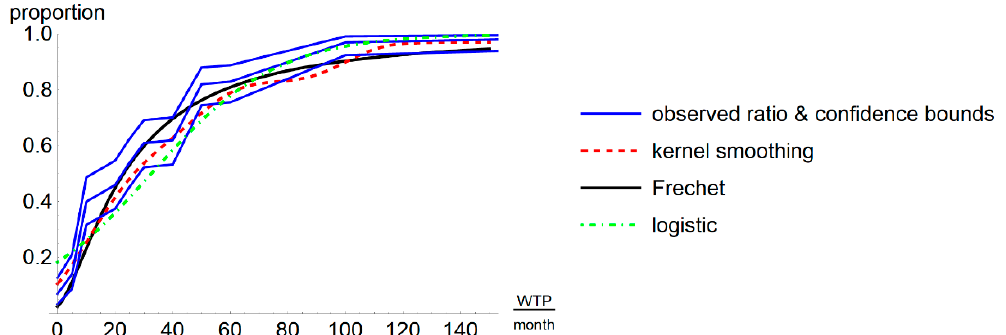
Figure 7. Cumulative distribution functions related to users’ WTP (INR/month), based on the Raisen 2015-survey (100 data). It plots the observed proportions for the percent of HHs willing to pay at most x INR/month sewerage charge and the one-sided 95% Clopper–Pearson confidence limits (blue; Section 9, Equation (3)), the cumulative smooth-kernel distribution function (dashed red), the cumulative Frechet distribution (black) and the cumulative logistic distribution (dot-dashed green) with the parameters of Figure 6; plot and computation using Mathematica 11.3.